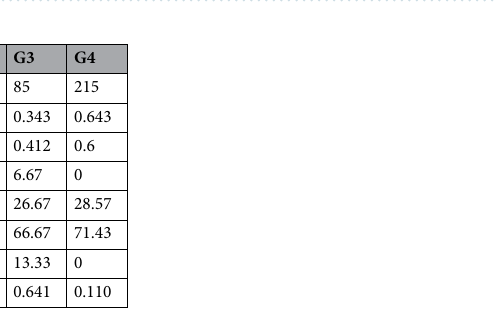
Figure 1. Social network diagrams for study groups (G1-G4). Nodes represent individual rats and their size is proportional to an individual’s network strength. Edge thickness represents the association index (SRI) between individuals. The three letter codes indicate individual rats’ names.